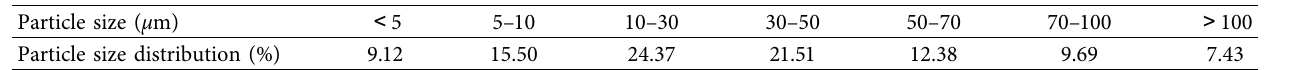
Table 3: Particle size distribution of fly ash.